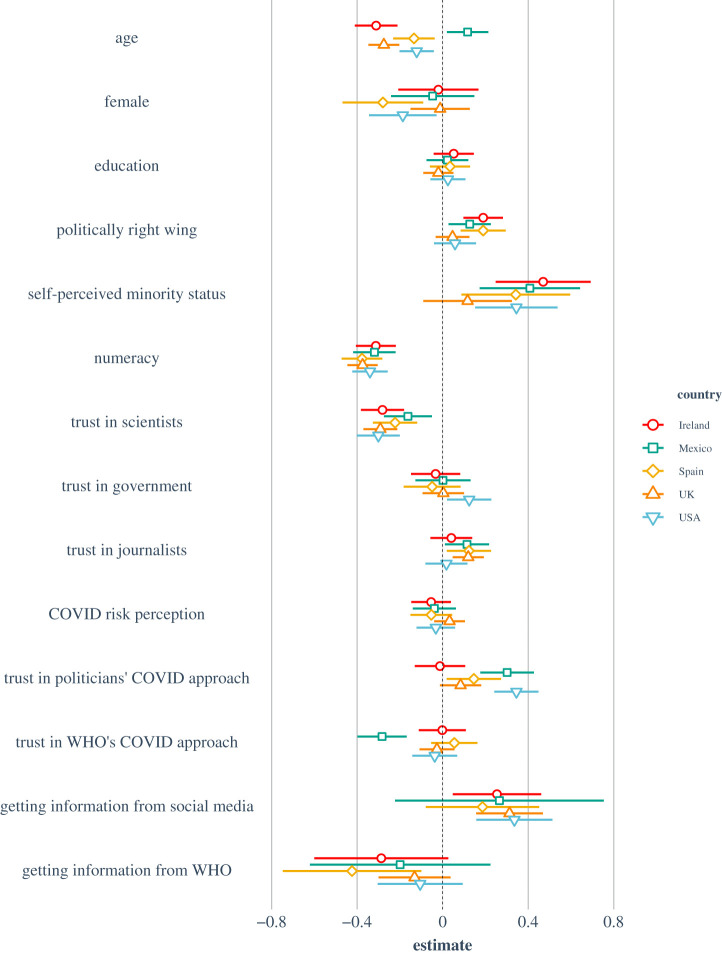
OLS multiple linear regression model for susceptibility to misinformation about COVID-19 by country. Note: results are mean-centred and scaled by 1 s.d. for comparability. Left of the dotted line (i.e. negative values) indicates reduced susceptibility to misinformation.